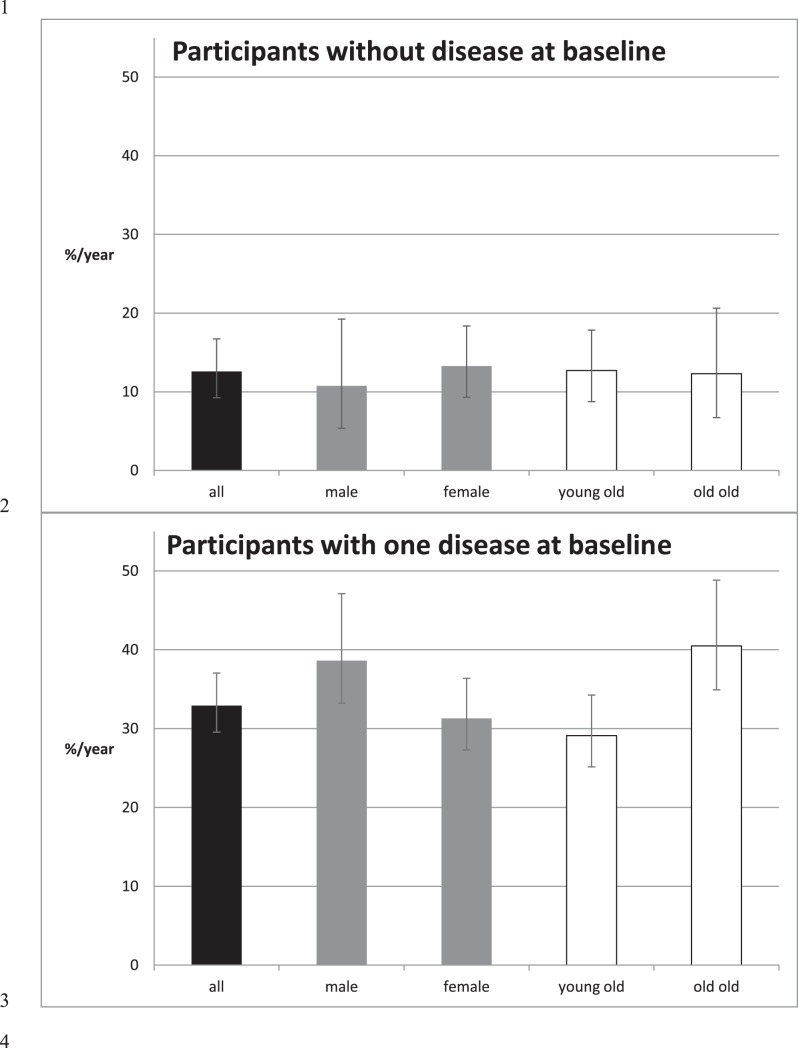
Multimorbidity (two or more diseases) incidence rates (95% confidence intervals) for participants without and with one disease at baseline (black) and by sex (grey) and age category (young old: <85 years and old old: ≥85 years, white).